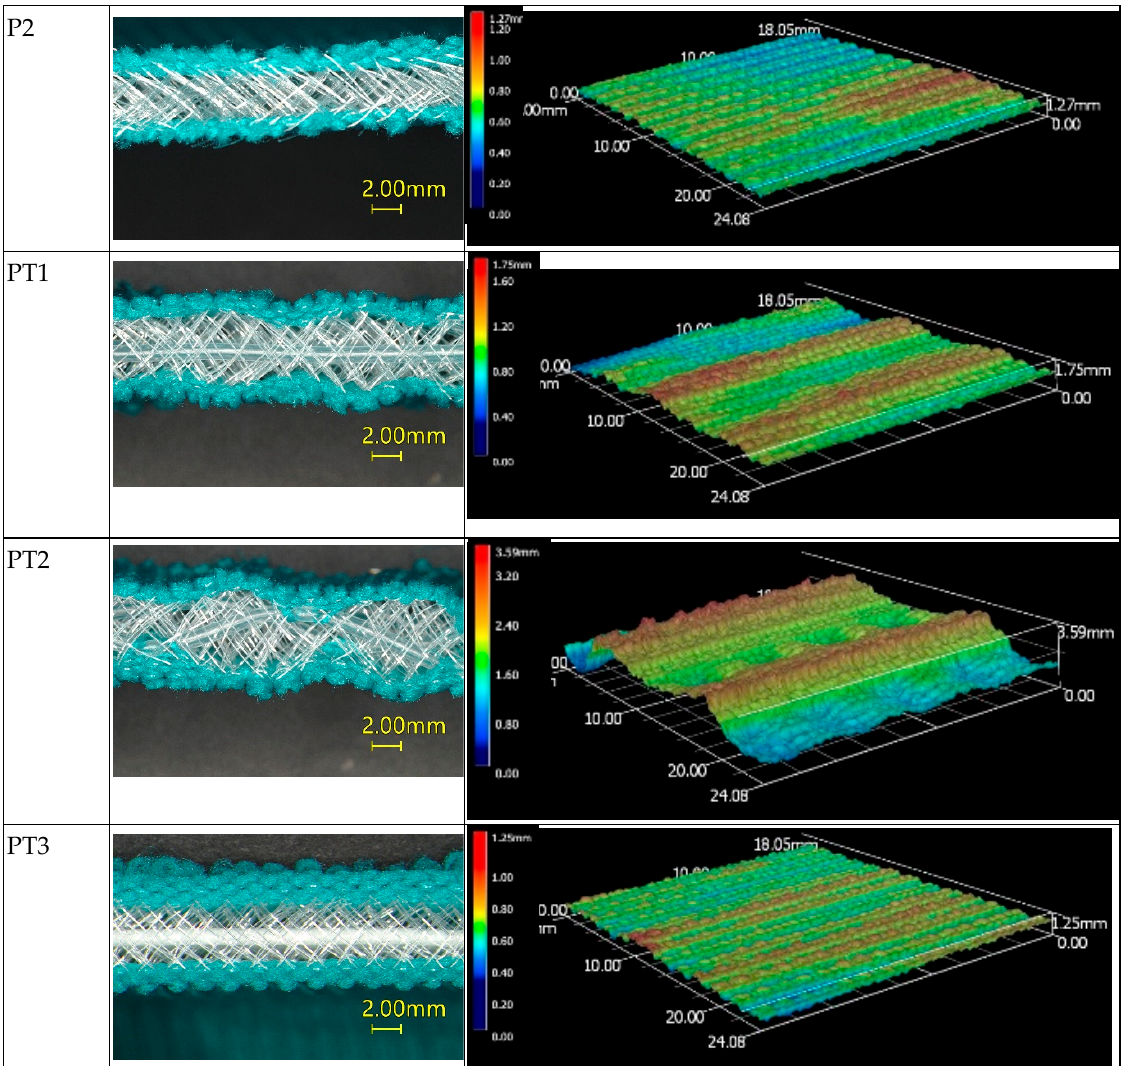
Figure 2. Spacer fabric samples geometry.